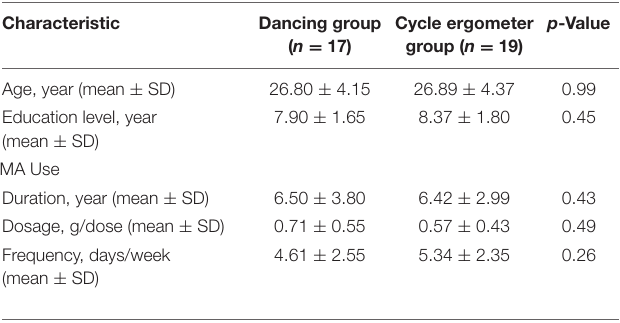
TABLE 2 | Valence and arousal scores of images considered positive, negative, or neutral before exercise intervention in 36 women with methamphetamine use